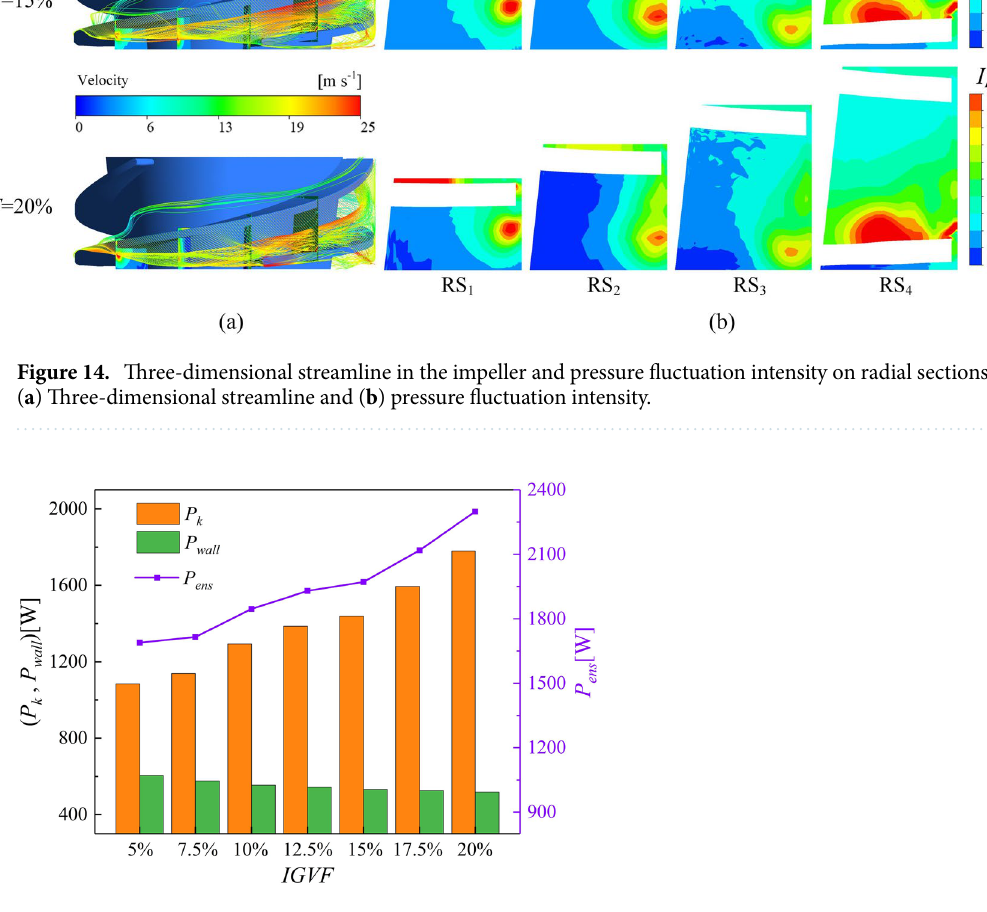
Figure 15. Variation in enstrophy dissipation power with